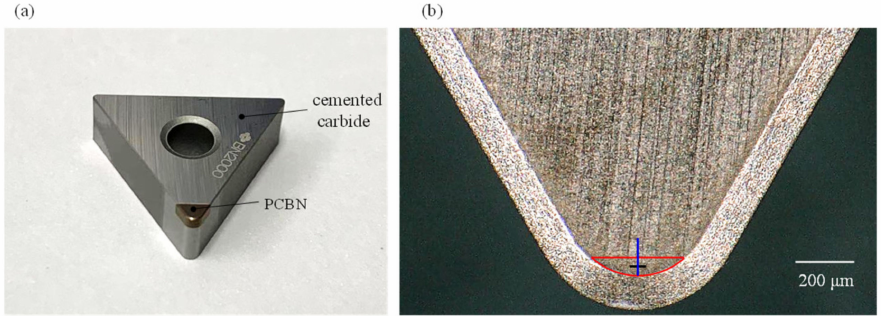
Figure 2. ( a ) PCBN cutting tools. ( b ) Optical microscope image of PCBN tool